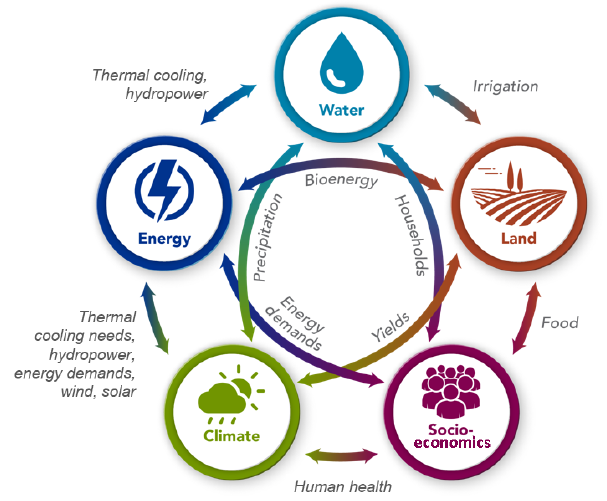
Figure 1. Linkages between the five major systems (energy, water, land, socioeconomics, and climate) in GCAM